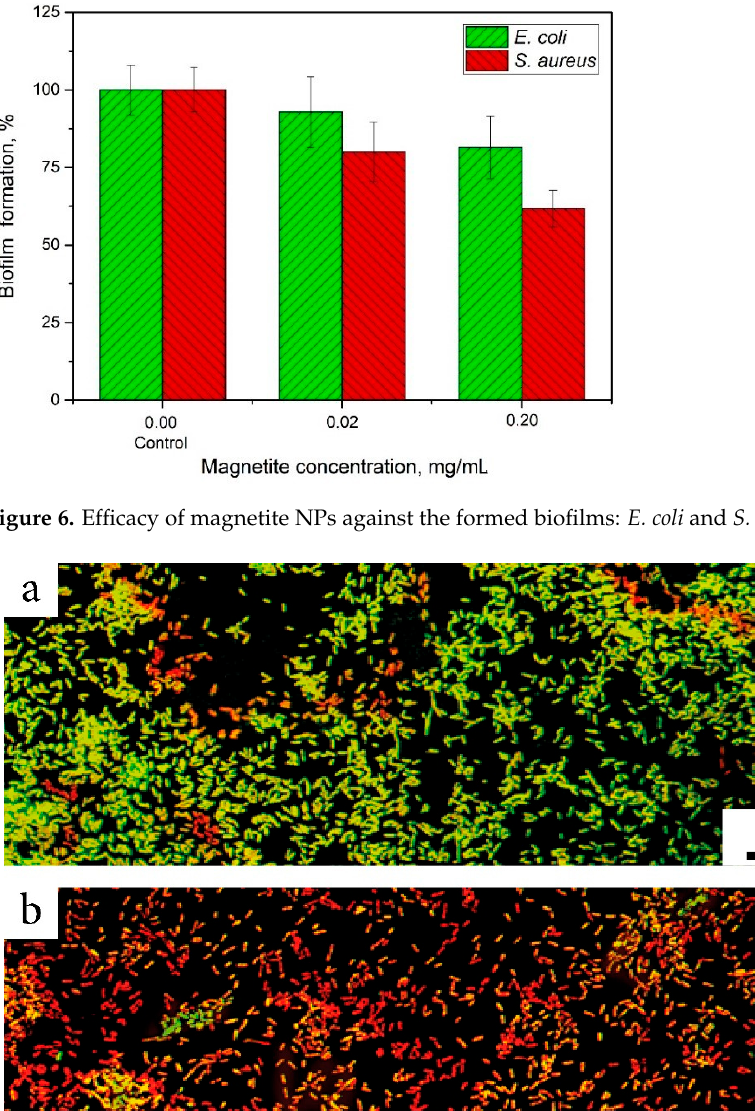
Figure 6. Efficacy of magnetite NPs against the formed biofilms: E. coli and S. aureus .